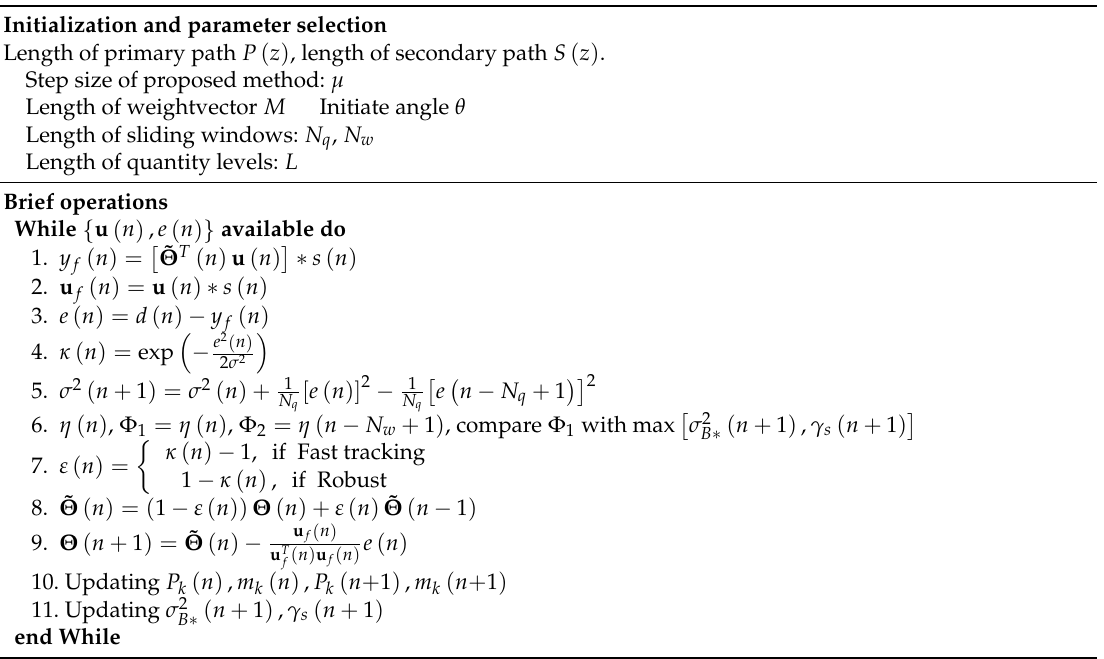
Figure 3. Frequency responses of the primary path and secondary path for a real duct ANC system. Table 1. Operations of the proposed DMPFxNLMS method.